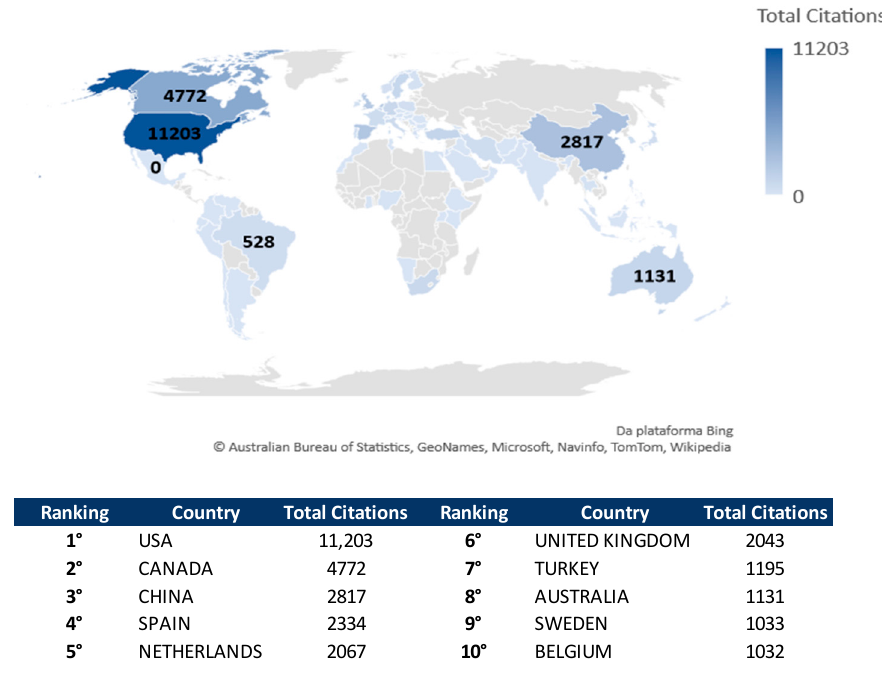
Figure 7. Most cited countries.